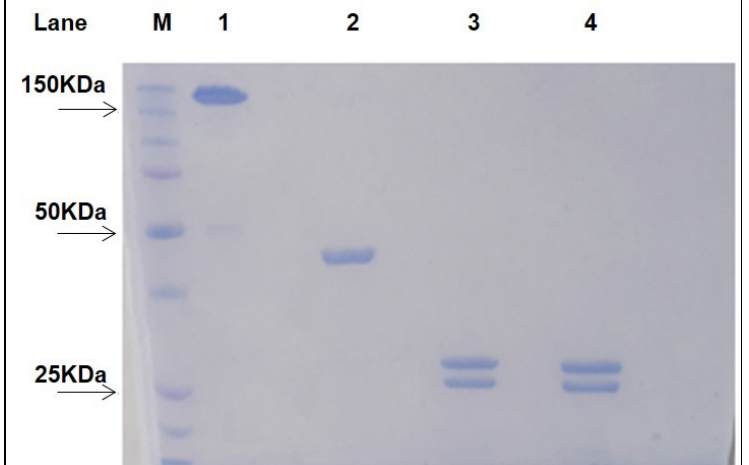
Figure 1. SDS-PAGE of purified Ritux Fab2 and Ritux Fab. The two samples were loaded under non- reducing and reducing (lanes 3–4) conditions, respectively. Lane 1: non reduced Ritux Fab2 ; Lane 2: non reduced Ritux Fab ; Lane 3: reduced Ritux Fab2 ; Lane 4: reduced Ritux Fab ; Lane M: Protein Precision Blue MW Marker (Biorad) used as reference.